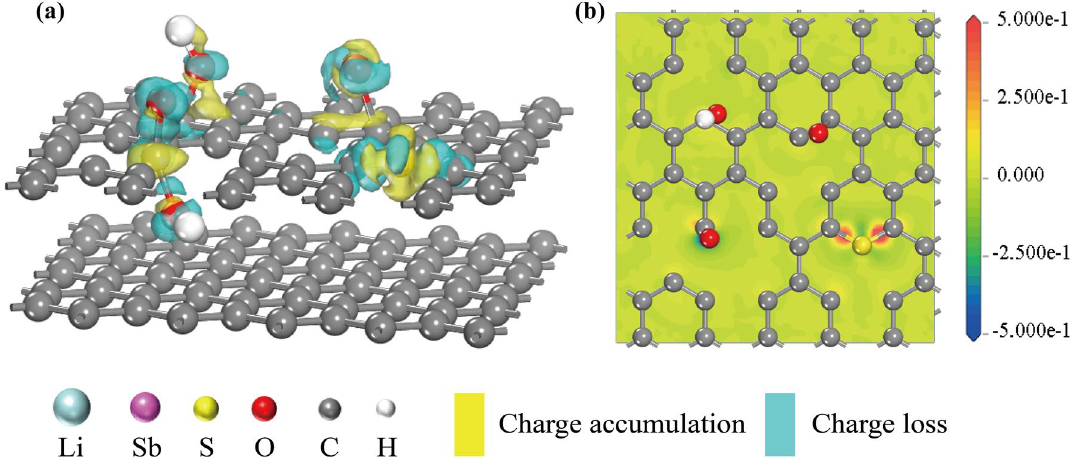
Fig. 9 The charge density of the oxygen-containing functional groups on the carbon